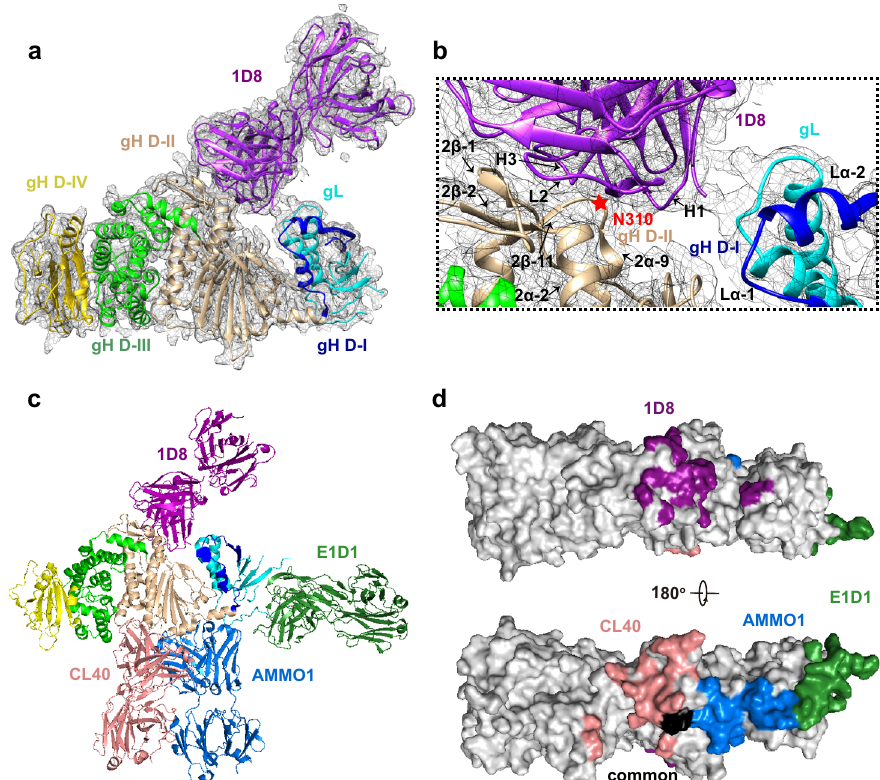
Fig. 4 1D8 targets a novel epitope on gH/gL. a Structure overview in a cartoon representation with gL in cyan, gH D-I in blue, D-II in wheat, D-III in green, D-IV in yellow, and 1D8 Fab in purple. The map is contoured at 1.2 RMS to show the density. b Zoomed-in view of the interaction between 1D8 and D-I and D-II. The key binding residue N310 of gH was indicated by a red star. c Cartoon representation of Fab 1D8 and other previously published Fabs AMMO1, CL40, and E1D1 bound to a single gH/gL molecule. The color scheme for gH/gL is as in ( a ) whereas 1D8 Fab in purple, AMMO1 Fab in light blue, CL40 Fab in pink, and E1D1 Fab in dark green. d Surface mapping of the four Fab epitopes on gH/gL with the same color in ( c ). Areas in black indicate the region where structural change was found upon binding to AMMO1 or